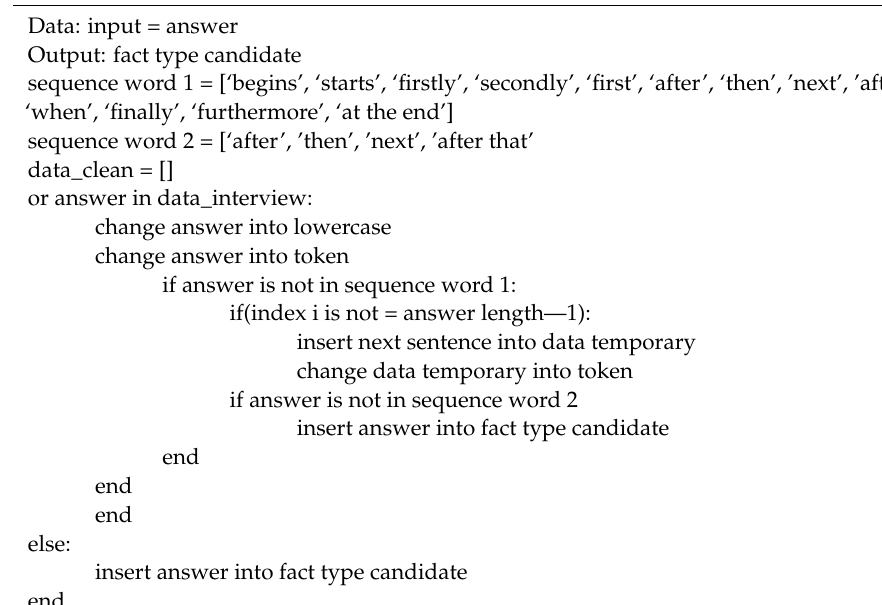
Algorithm 1. Fact type candidate based on sequence words